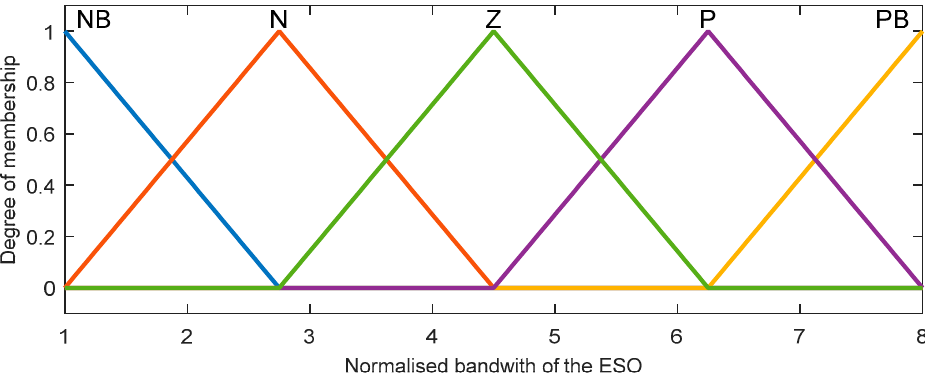
Figure 3. Membership functions of the proposed fuzzy gains ‐ scheduling mechanism.